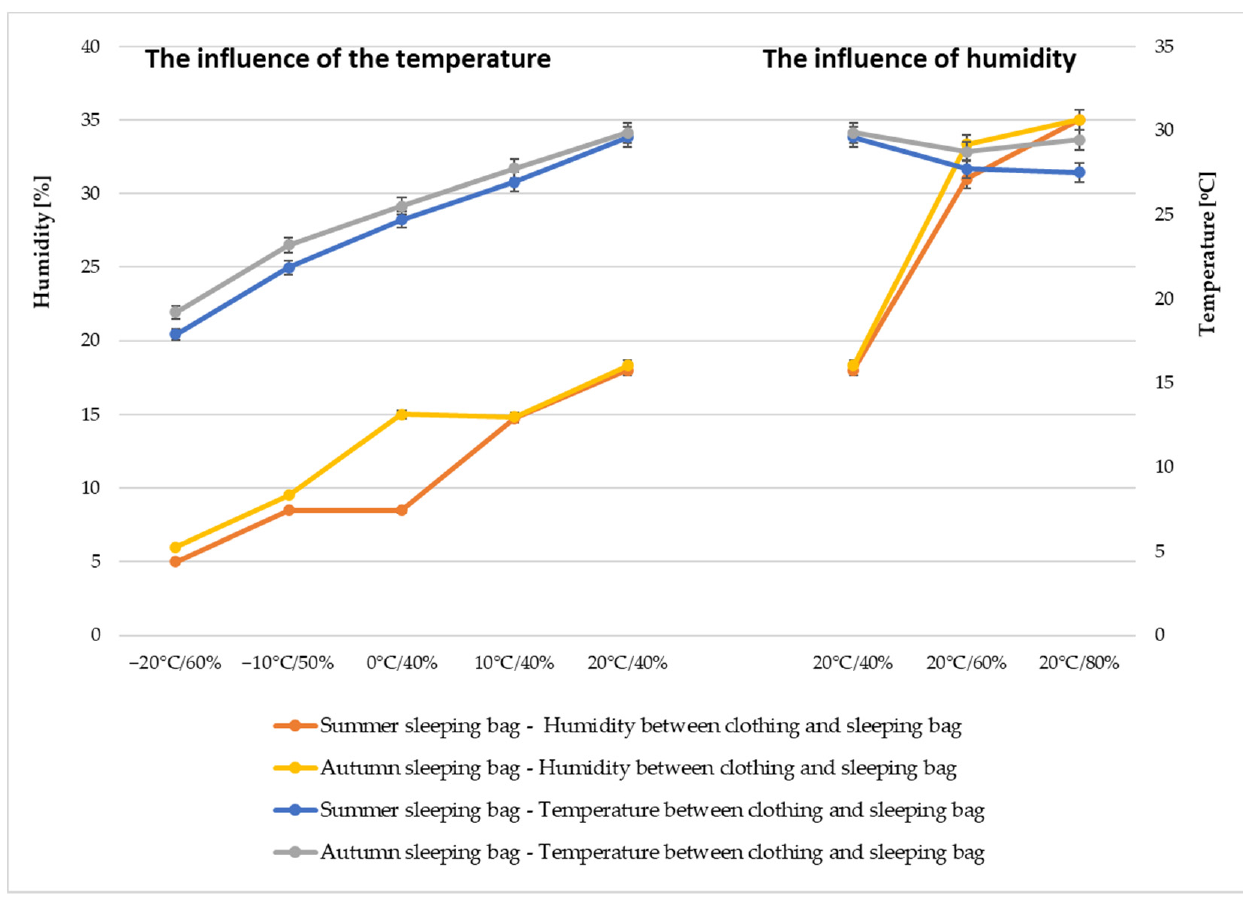
Figure 11. Average humidity and temperature obtained between the clothing and the sleeping bag under different weather conditions. Table 9. Average air permeability of both sleeping